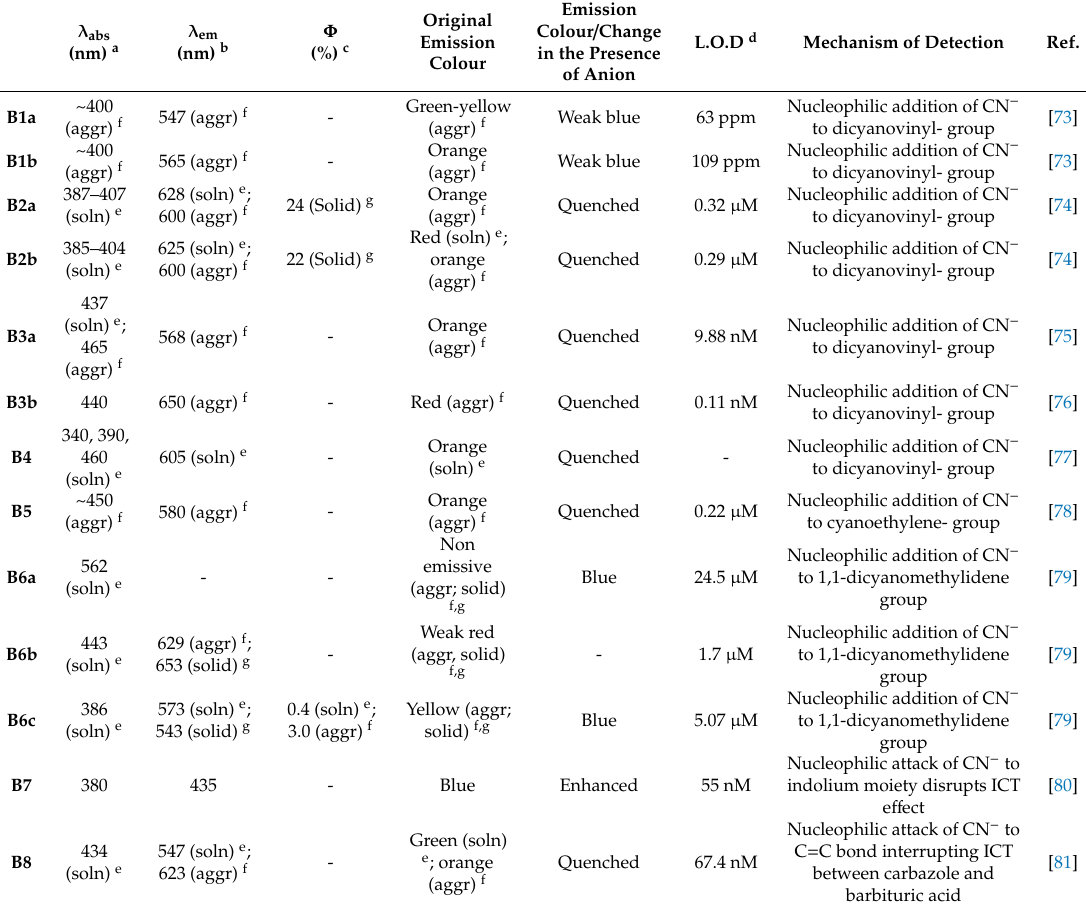
Table 5. Summary of optical properties and sensing performance of AIE-based cyanide chemosensors B1a – B14